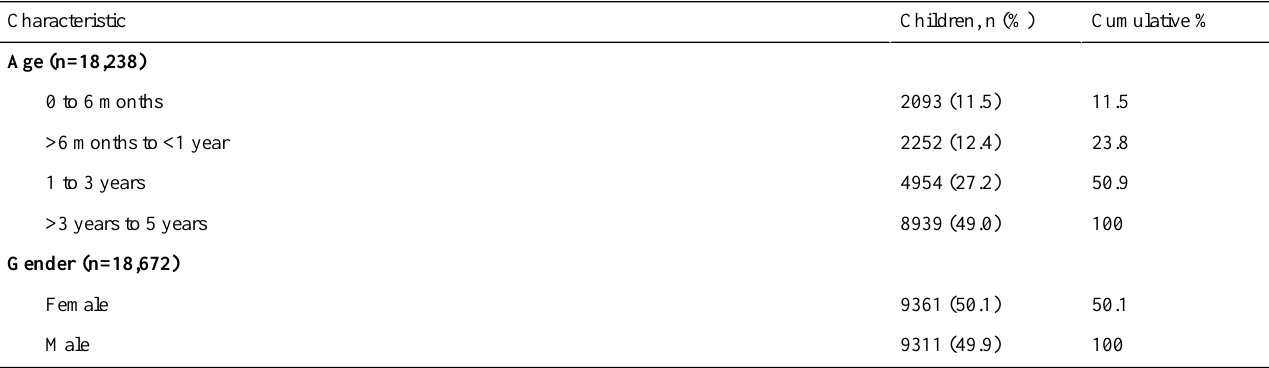
Table 3. Characteristics of children to whom respondents referred in the survey.